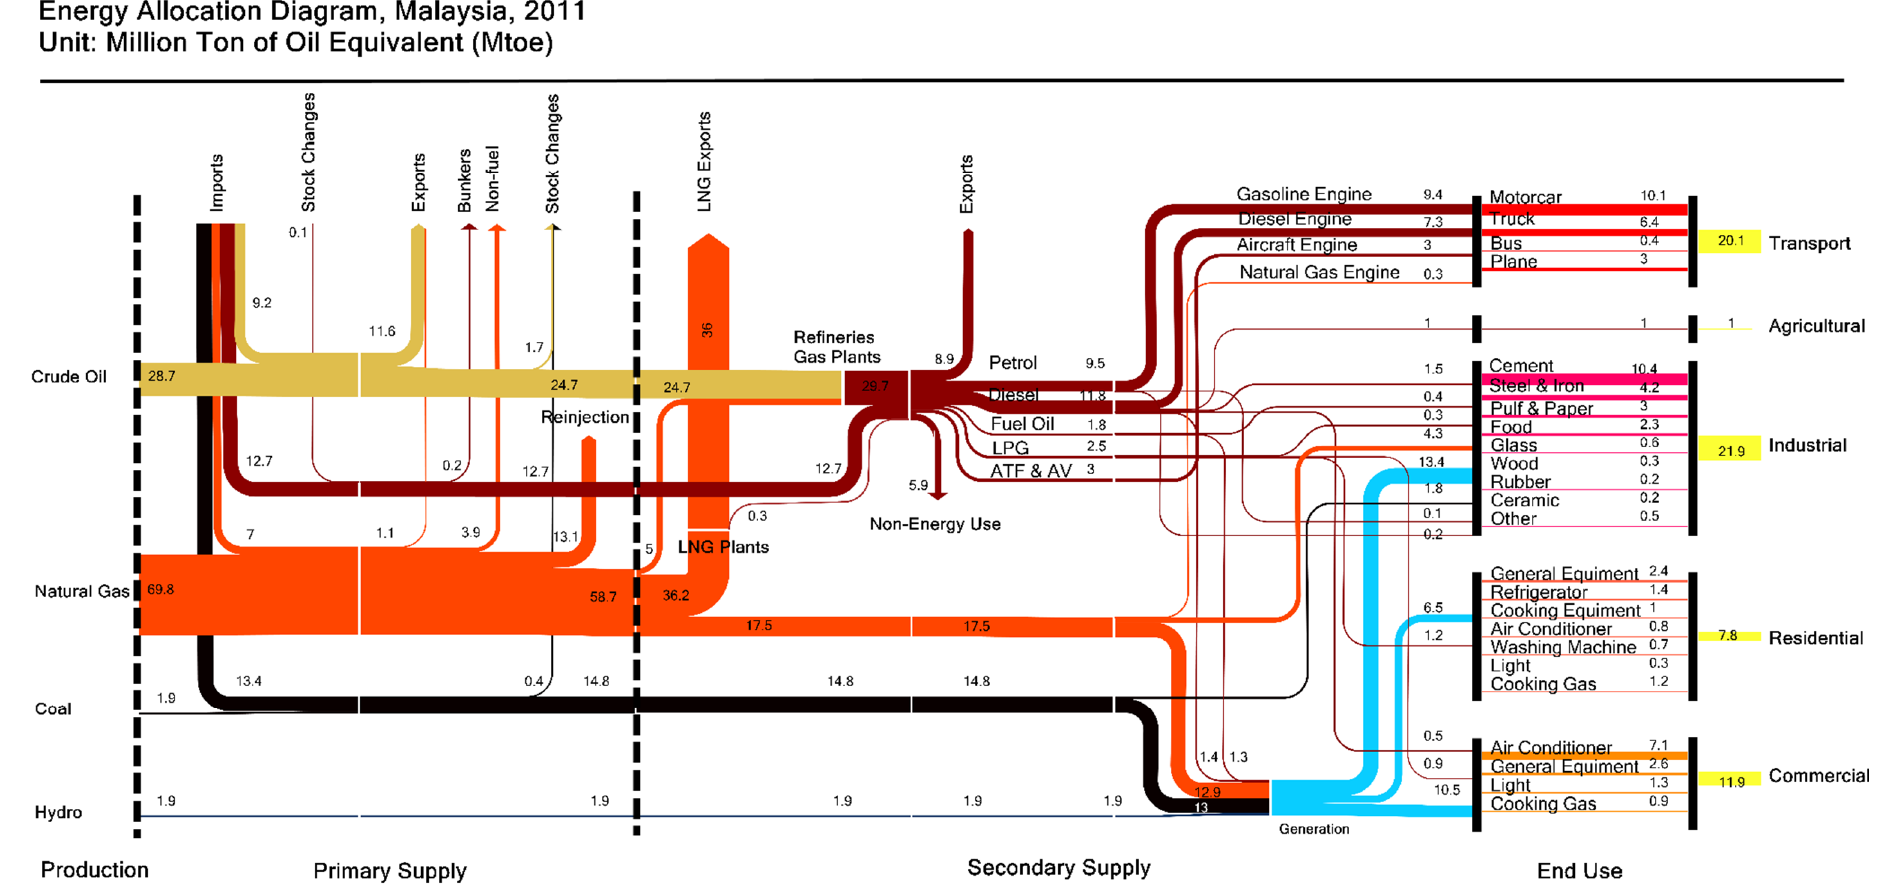
Figure 2. Malaysia energy allocation diagram,